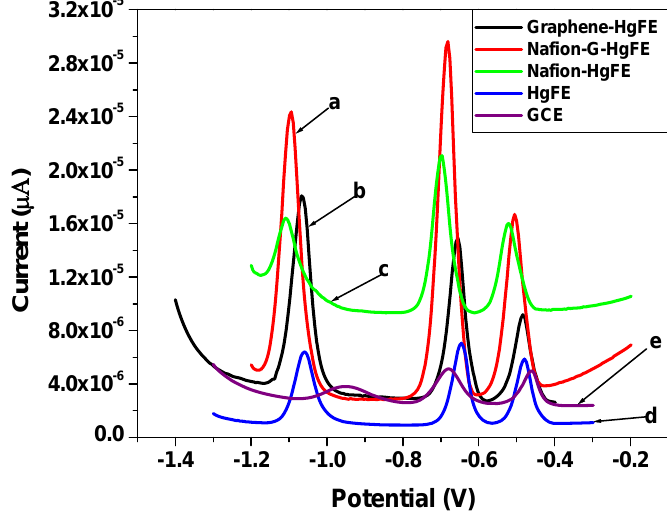
Figure 6. SWASV of 30 µg L − 1 of Zn 2+ , Cd 2+ and Pb 2+ on (a) Nafion-G HgFE, (b) Graphene HgFE, (c) Nafion HgFE, (d) HgFE and (e) glassy carbon electrode in 0.1 M acetate buffer (pH